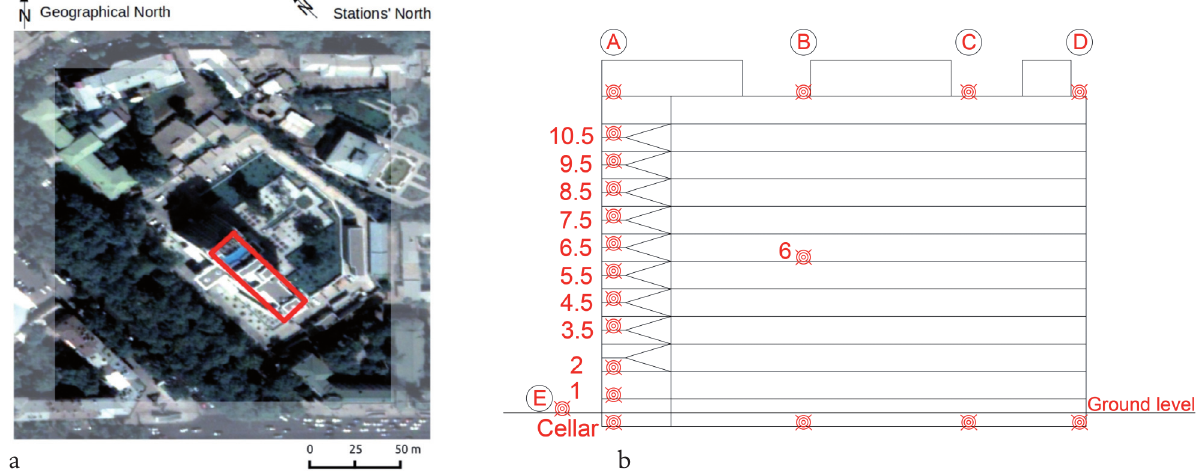
Figure 6. (a) Satellite image and (b) cross-section of the Serena Hotel (Figure 2,IV), showing the locations of the installed stations (red symbols).